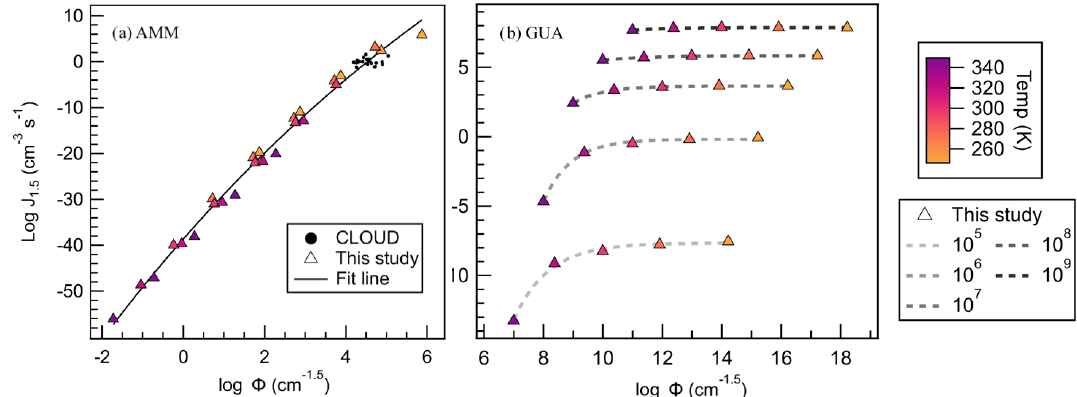
Figure 12. (a) AMM–SA and (b) GUA–SA salts’ J 4 × 4 plotted against (cid:56) , where triangles are colored according to the temperature of that point’s calculation. CLOUD data are shown as black dots, and their (cid:56) values were calculated according to Eq. (5). All trendlines used an exponential